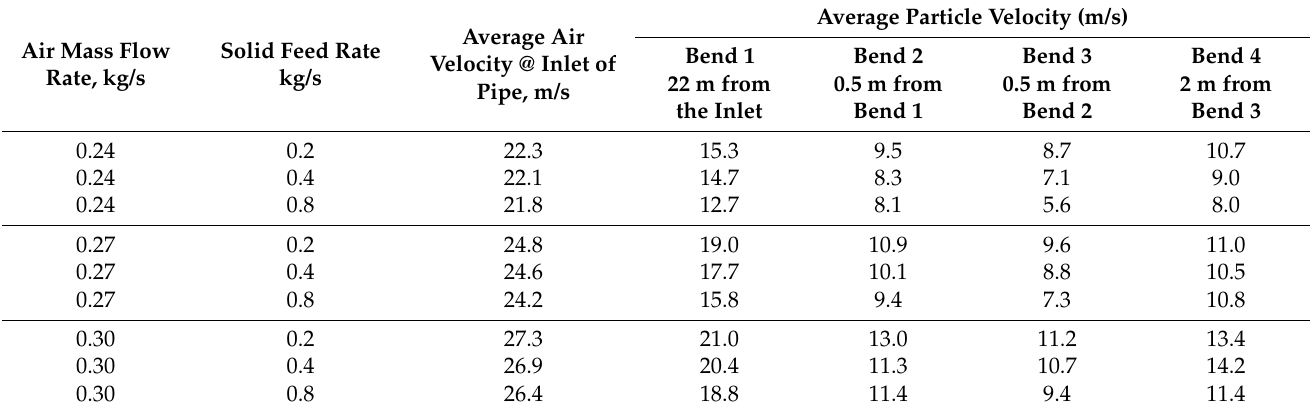
Table 7. Particle velocity measurements for aged pellets with bends in proximity.